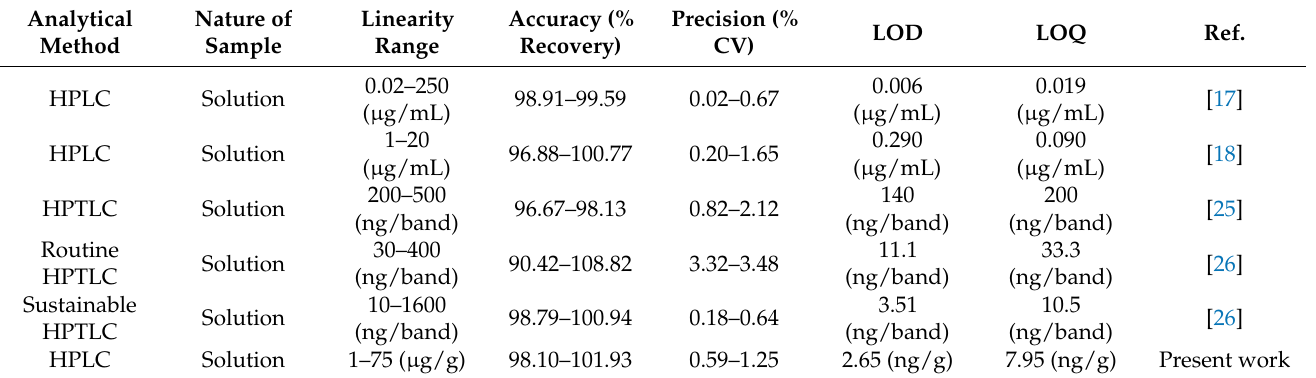
Table 7. Comparative summary of validation parameters of the present HPLC method with reported methods for the determination of